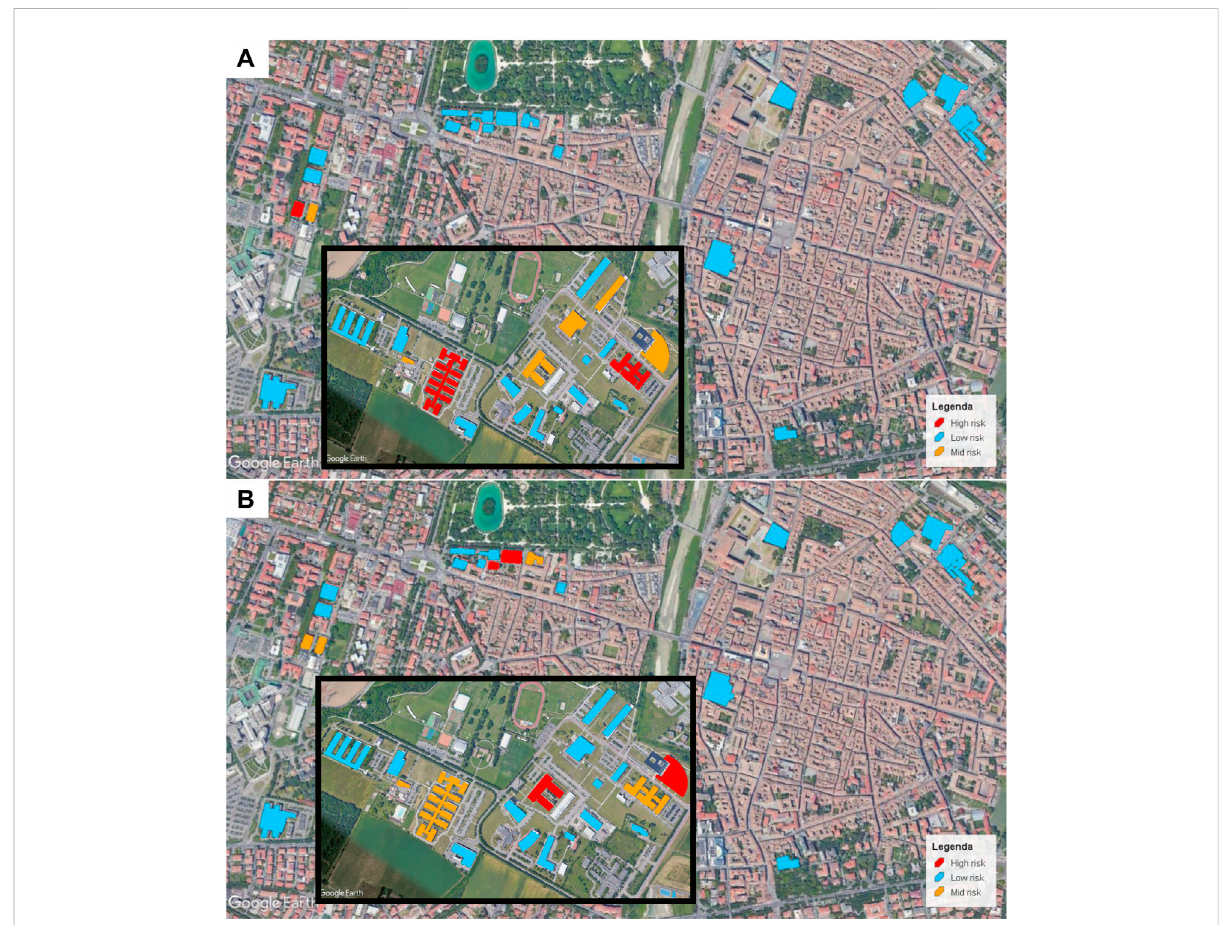
Geographical map of buildings with critical APs. Map of Parma with the university buildings in three different colors based on the number of critical APs inside. (A) refers to the APs ’ rank in Figure 10 of the partial opening period, while (B) refers to the total opening period with the ranking of theAPs given inFigure11.The lightbluecolor represents thebuildingswhere there areno APs inthe critical list,the yellowbuildings where there are oneortwocriticalAPs,andtheredbuildingswheretherearemorethantwocriticalAPsinthelist.Thereturnofface-to-facelessonscompletely changes the location of critical APs to different buildings, such as in the economics